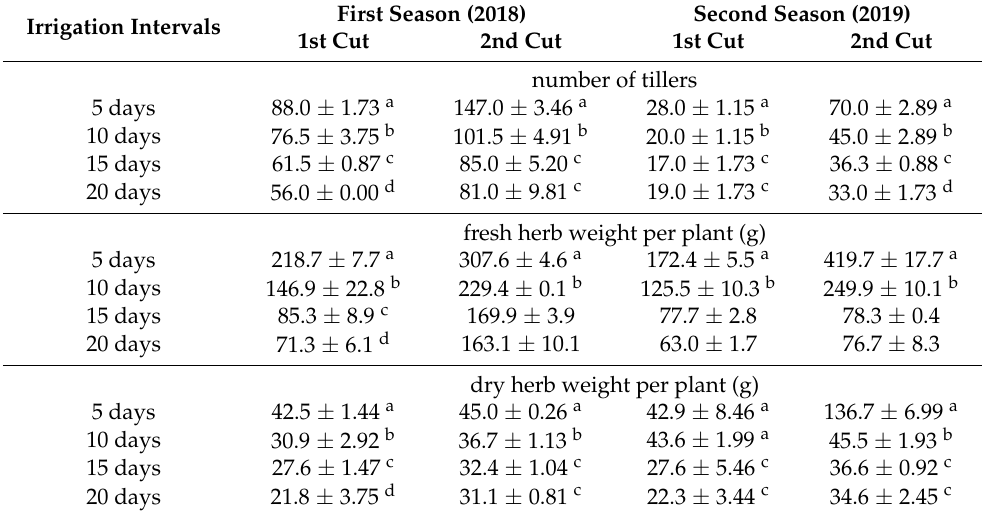
Table 2. Influence of irrigation intervals on the growth characteristics of lemongrass, number of tillers, fresh herb weight per plant, dry herb weight per plant, fresh herb yield per hectare, dry herb yield per hectare, leaf greenness, and proline content in the 1st and 2nd harvest of 2018 and 2019 seasons. Irrigation